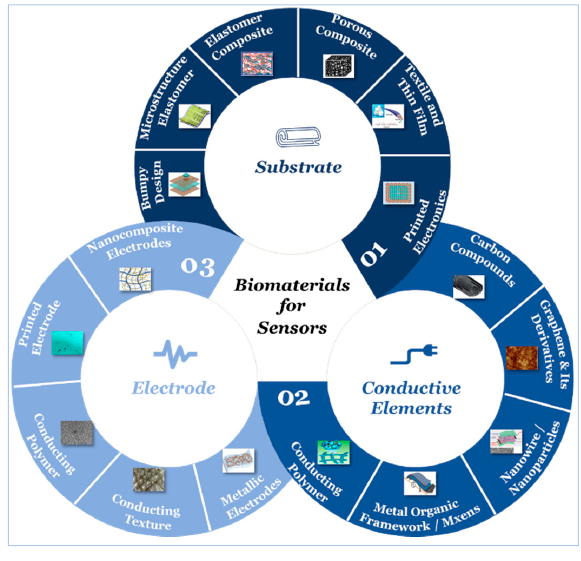
Figure 21. Use of biomaterials in sensor key components.